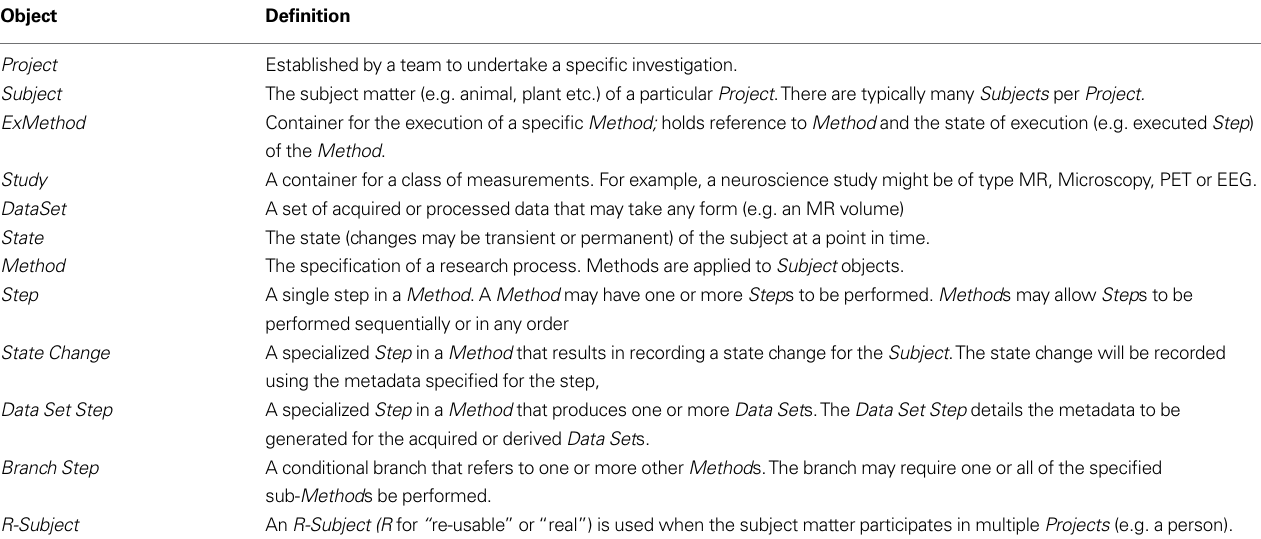
Table 1 | The object defi nitions for the Framework object model.